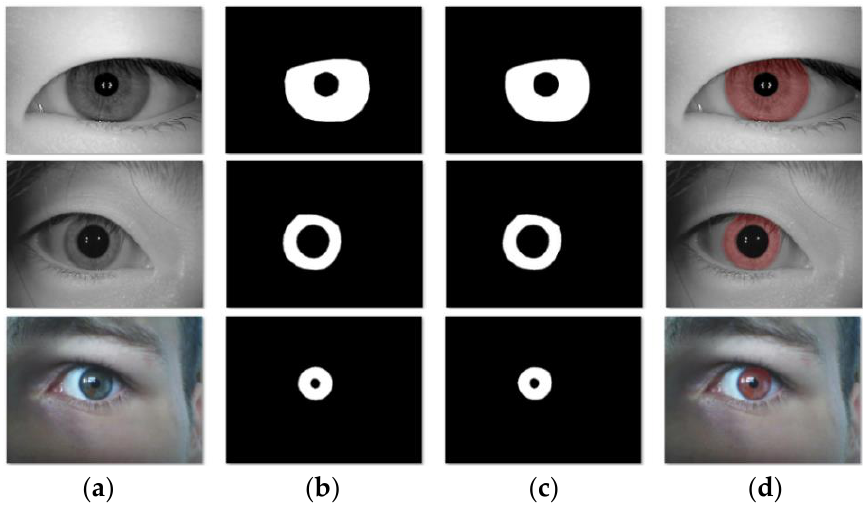
Figure 9. The accuracy curves of PFSegIris on the mixed iris training set and validation set.